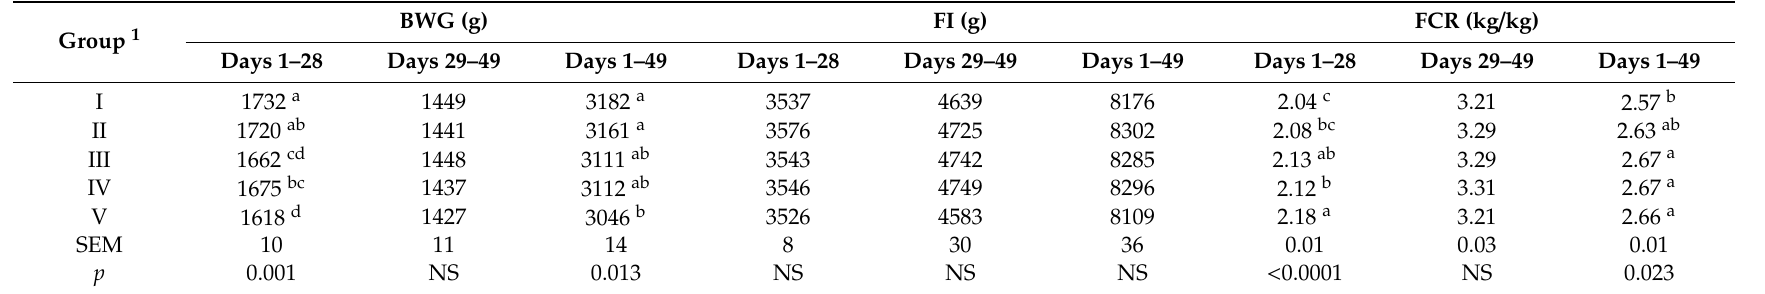
Table 4. Growth performance of ducks during the rearing